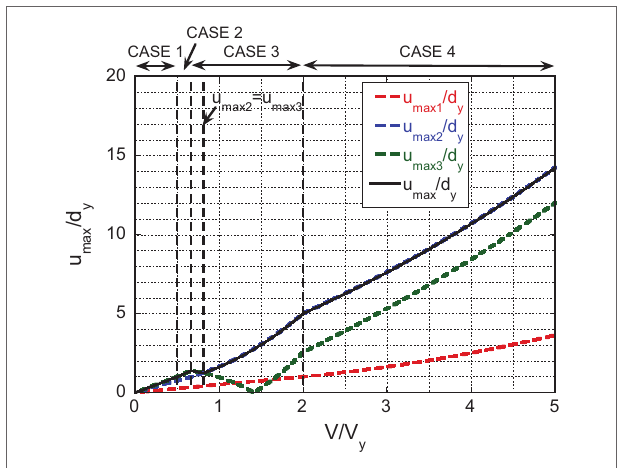
FigUre 4 | Maximum normalized elastic–plastic deformation under triple impulse with respect to input level